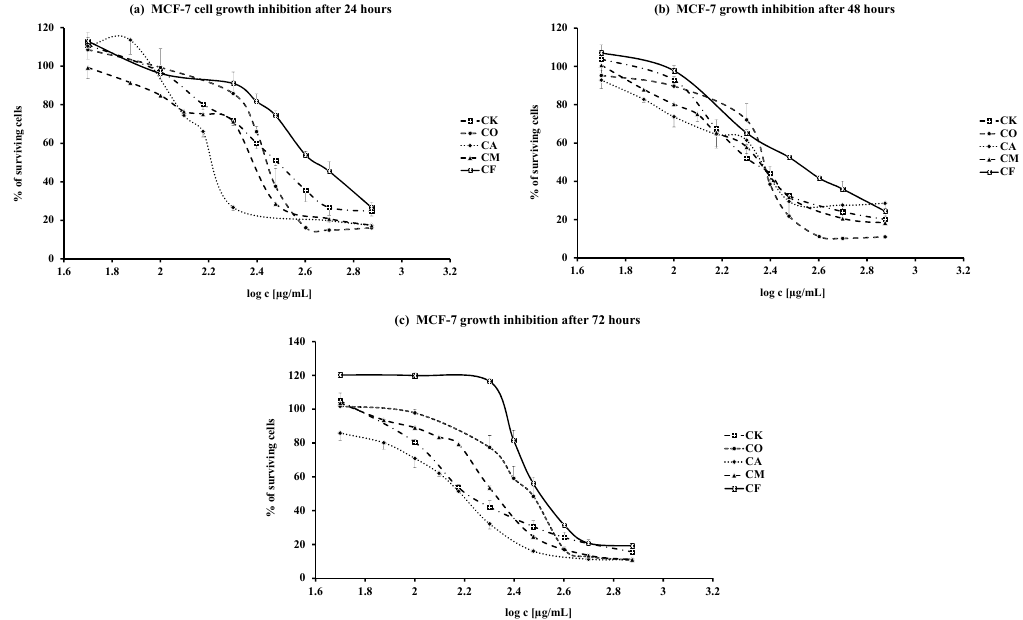
Figure 1. ( a – c ) Time and dose dependent MCF-7 cells growth inhibition after 24( a ); 48( b ); and 72( c ) hours treatment with leaves water extracts from Cornus species (CA— Cornus alba , CO— C. officinalis , CK— C. kousa , CM— C. mas , CF— C. flaviramea ). Table 3. Correlation coefficients (R) and statistical signifficance ( p <) for the relationship between max. effect (% of cell survival) and the content of secondary